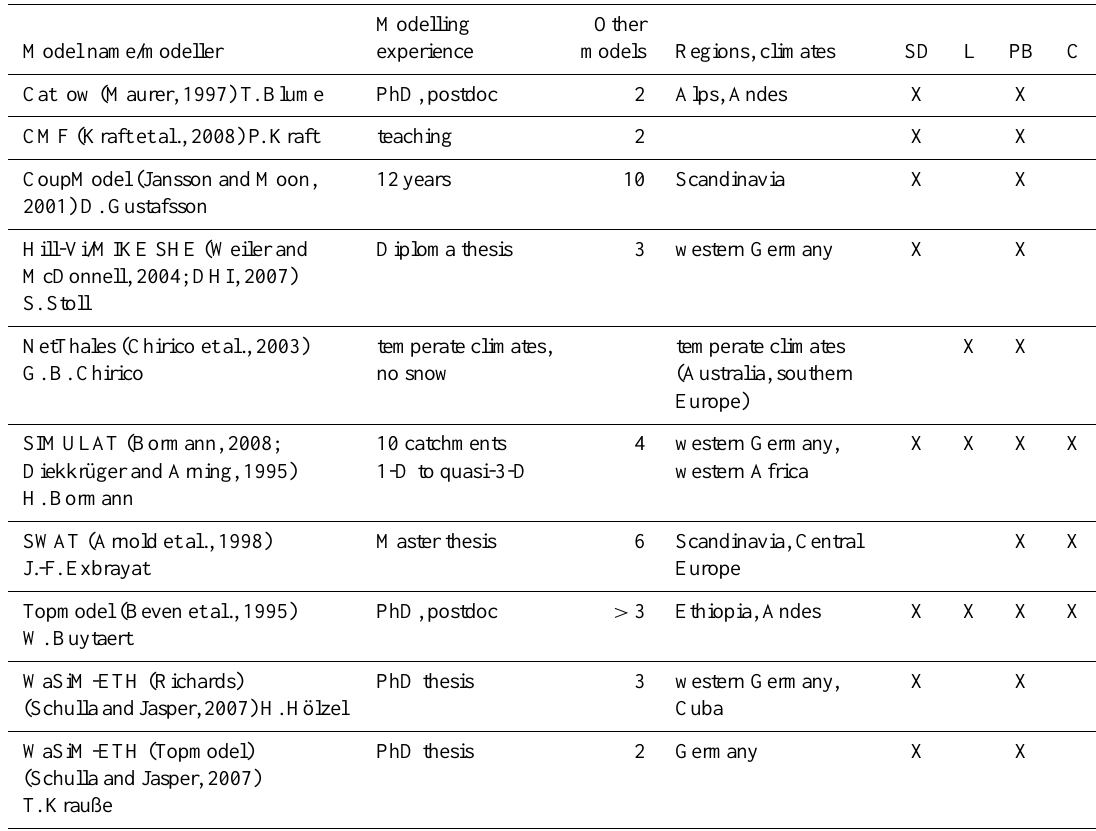
Table 1. Prior modelling experience (SD=fully or partially) spatially distributed, L=lumped, PB=physically based, and C=conceptual). Modelling Other Model name/modeller experience models Regions,